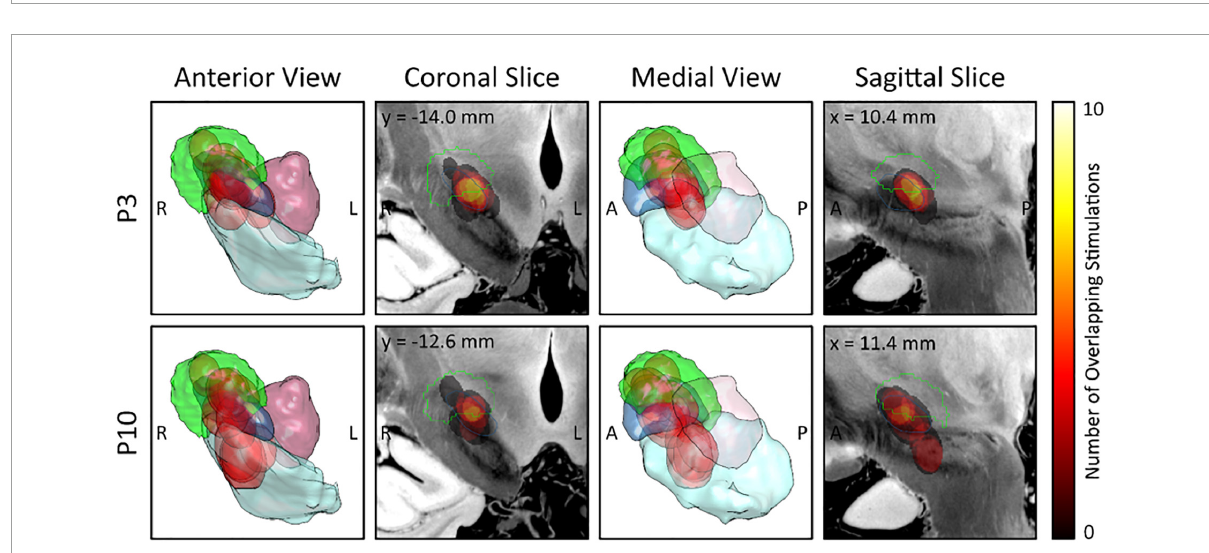
FIGURE3 Electric field (EF) overlap to the sweet spot atlas for each deep brain stimulation (DBS)-contact with the highest evoked potential (EP) peak. EF overlap with the sweet spot is shown for each DBS-contact with the highest P3 peak (upper row; n = 9) and for each DBS-contact with the highest P10 peak (lower row, n = 11). 3D views from anterior (first column) and medial (third column) as well as slices through the weighted-mean-effect image (coronal, second column; sagittal, fourth column) are provided. The Dembek sweet spot (overall motor improvement) is shown in green and the different EFs in red. Anatomic structures: subthalamic nucleus (blue); substantia nigra (mint); red nucleus (lilac). R, right; L, left; A, anterior; P,